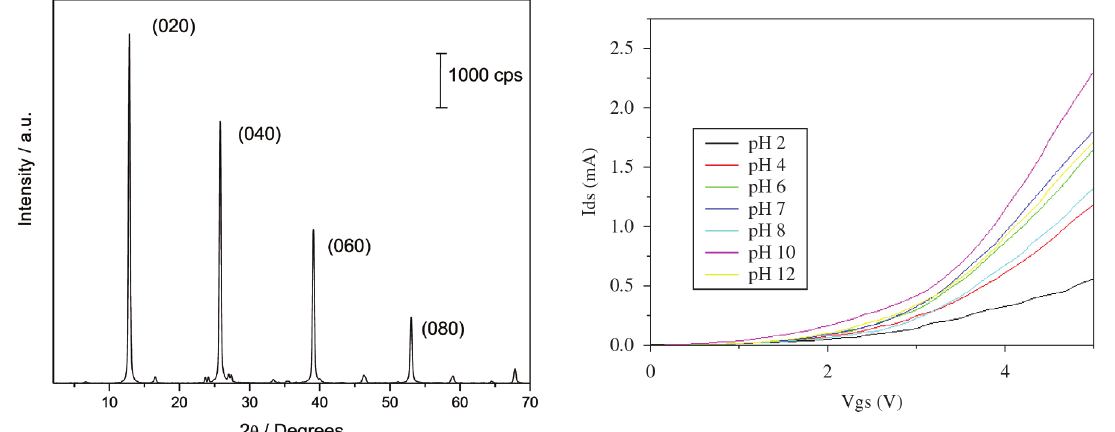
Figure 3. EGFET response in linear region (drain–source current as a function of gate–source voltage) using WO 3.